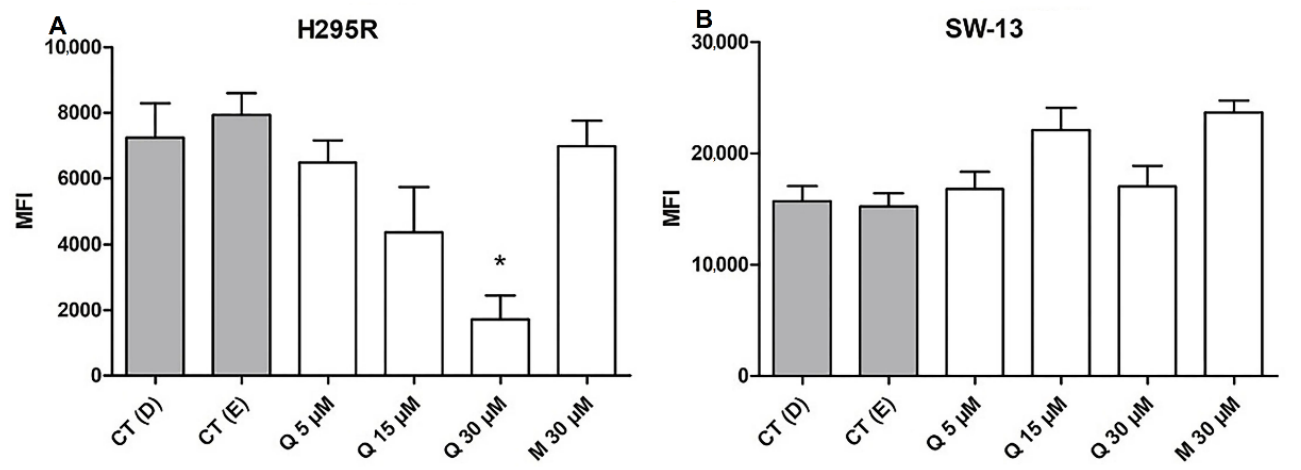
Figure 8. Quercetin performs distinct effects on reactive oxygen species (ROS) generation. ( A ) Median of fluorescence intensity (MFI) of 2′,7′ -Dichlorofluorescin diacetate (DCFH-DA) on H295R cells; ( B ) MFI of DCFH-DA on SW-13 cells. * ( p < 0.05) in comparison with respective controls.